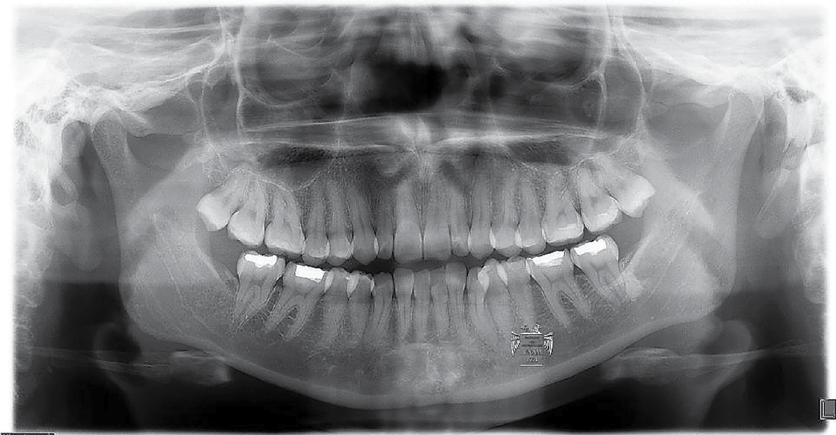
Figure 2- Case 6. Radiopaque gigantic lesion located in the anterior mandible. Two microdontic lateral incisors, dilaceration of the right canine and a small radiopaque zone in the mandibular right third molar correspondent to a condensing osteitis are seen